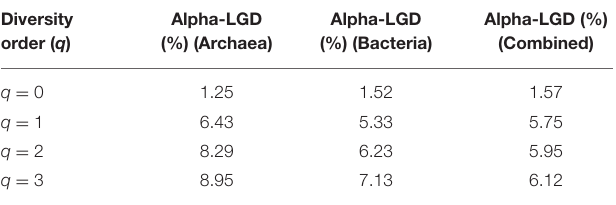
TABLE 4 | The LGD (the ratio of local diversity to global maximal accrual diversity) profile for the archaea, bacteria, and combined communities in the hot springs. Diversity order ( q